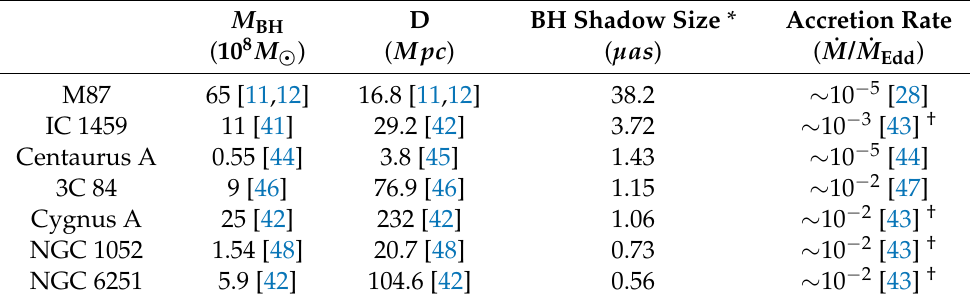
Table 1. Selected example LLAGN sources with jet